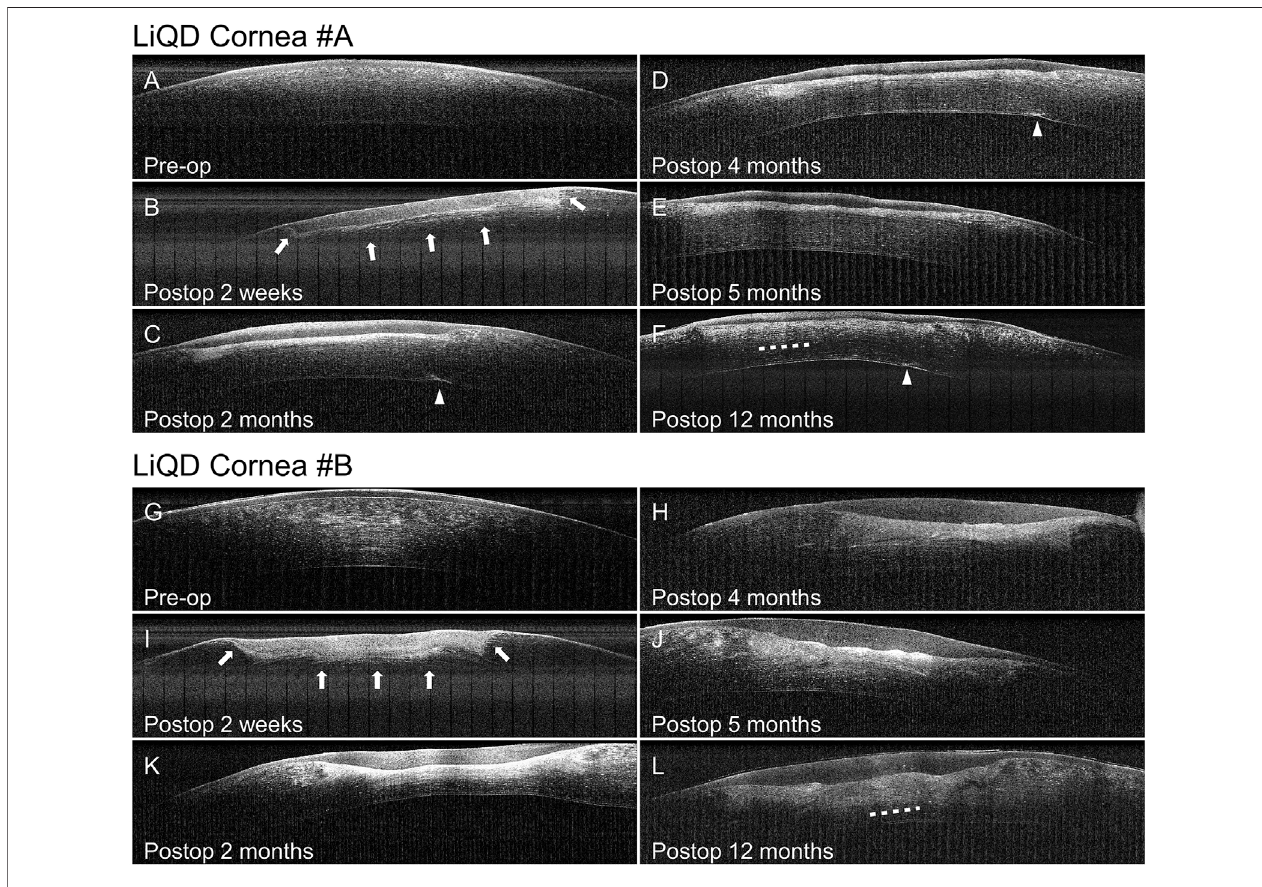
FIGURE 3 | Optical coherence tomography. Progressive replacement of the fi ller by the regenerated stroma in animal #A (A – F) and animal #B (G – L) . Arrows indicatethechangeindensity progressingfromtheinterfacebetweentheimplantand thewoundbed towardtheanterioraspectofthe fi ller.Arrowheadsarepointingto the site of needle perforation in animal #A. Dotted lines indicate the presumed transition zone between the native stroma and the regenerated neostroma.